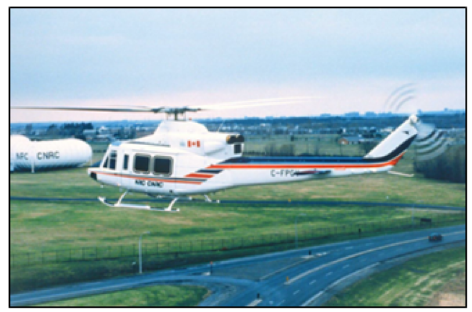
Fig. 2 Bell 412HP advanced systems research aircraft